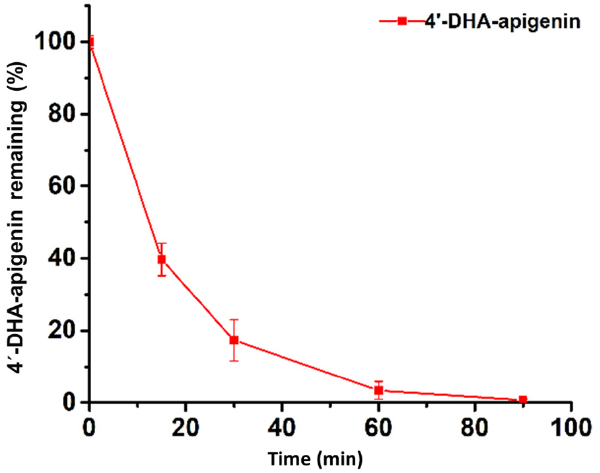
Figure 5. Degradation rate of 4 ′ -DHA-apigenin hybrid during incubation in human plasma for 90 min.